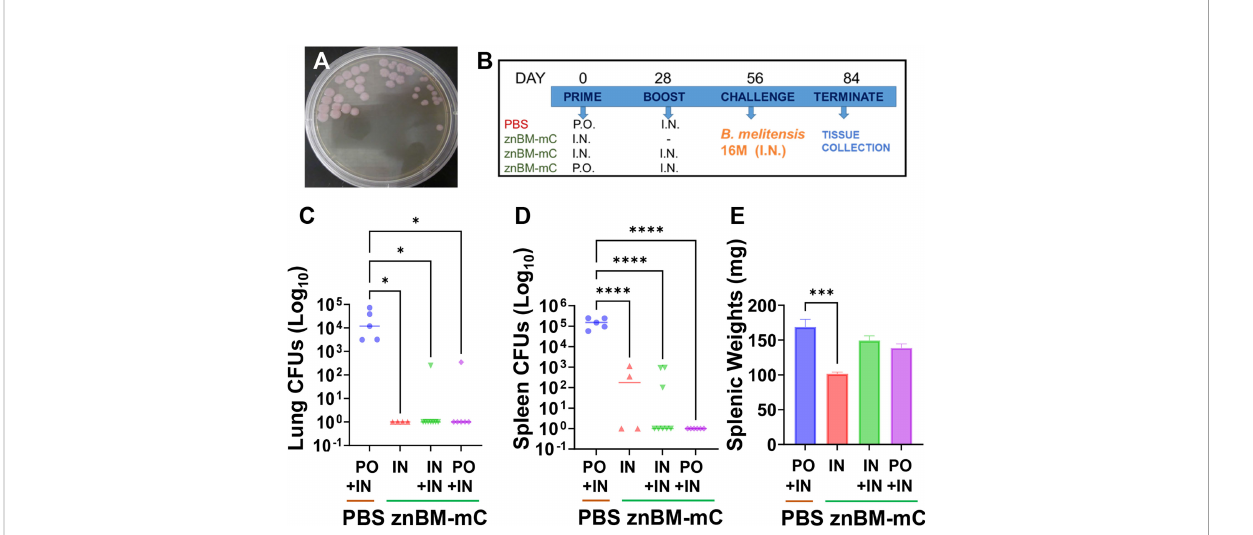
FIGURE 1 Oral prime, IN boost with znBM-mC confers potent protection against challenge with virulent B. melitensis 16M. (A) The znBM mutant was generated to express mCherry (noted as pink colonies on PIA) to readily distinguish znBM-mC from other Brucella strains. (B) Four groups of BALB/c mice were orally or IN vaccinated on day 0 with 10 9 CFUs znBM-mC, and controls were orally dosed with sterile PBS (sPBS) vehicle. On day 28, one oral and one IN groups were IN boosted with 10 9 CFUs znBM-mC; one nasal group was left unboosted and the PBS group was IN boosted with sPBS. On day 56, all mice were subjected to pulmonary challenge with 5 × 10 4 CFUs wt B. melitensis 16M. On day 84, individual lungs and spleens were collected for CFU enumeration. (C) All znBM-mC vaccinated mice showed a signi fi cant decrease in lung colonization compared to naïve controls. Mice receiving a single IN dose show sterile protection. (D) All znBM-mC-vaccinated mice showed a signi fi cant reduction in splenic colonization compared to naïve controls, particularly, the oral primed, IN boosted mice, which showed sterile protection in the spleens. (E) All vaccinated mice showed modest in fl ammation of the spleens, but those given a single IN dose of znBM-mC displayed signi fi cant reduction in splenic weight. Data depict results from fi ve to seven mice per group; * p <0.05, ***p <0.0005, and ****p